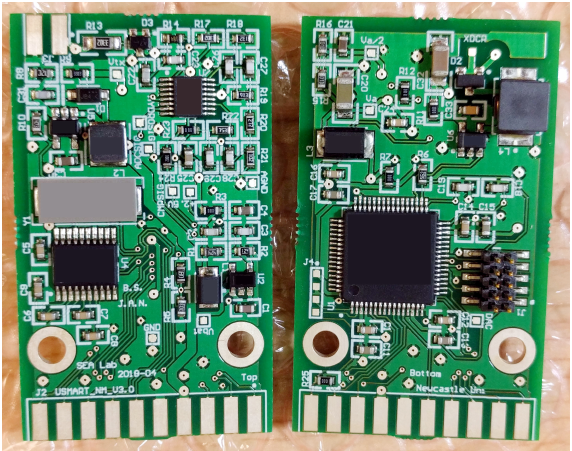
Figure 7. Photo of NMv3 PCB. Dimensions: 45.0mm by 27.0mm.